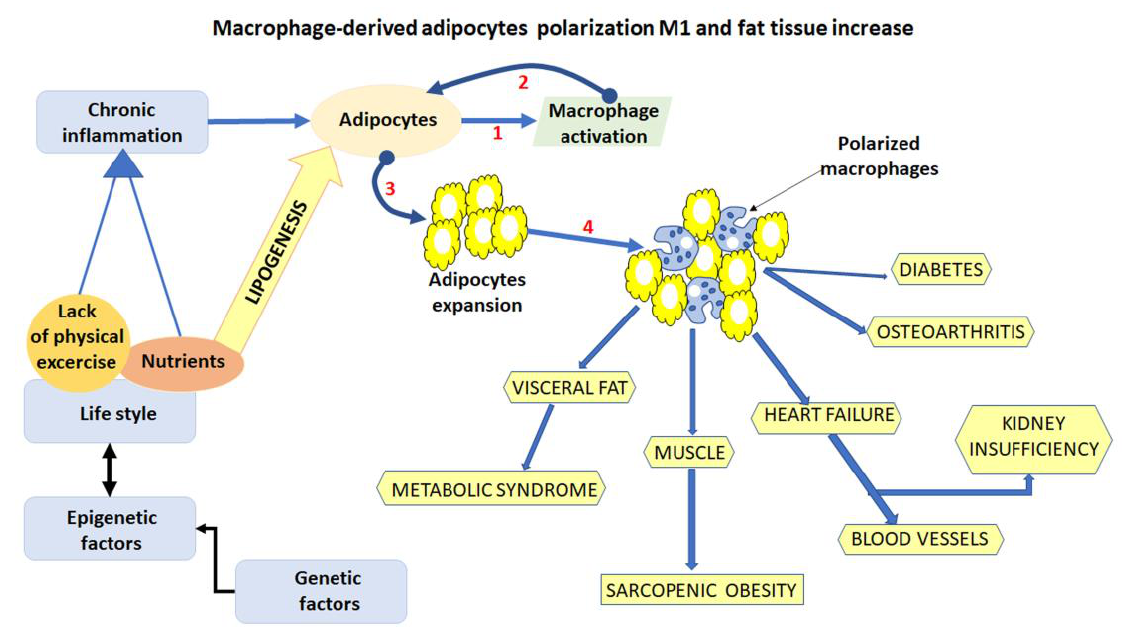
Figure 1. Schematic representation of the fat mass expansion and related diseases secondary to obe- sity. Adipocyte crosstalk macrophage (1) which in turn stimulate adipocyte inflammation (2) and expansion (3); inflamed hypertrophic adipocytes promote the accumulation of M1 polarized mac- rophages in adipose tissue